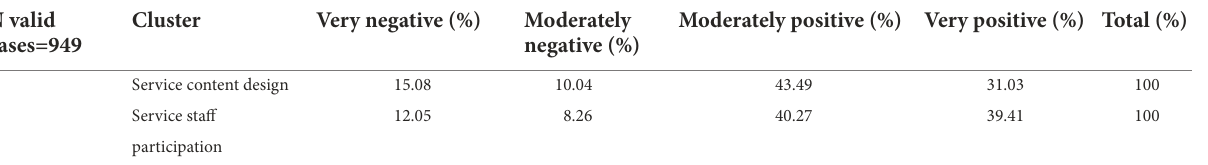
TABLE 6 Sentiment analysis of facilitating conditions